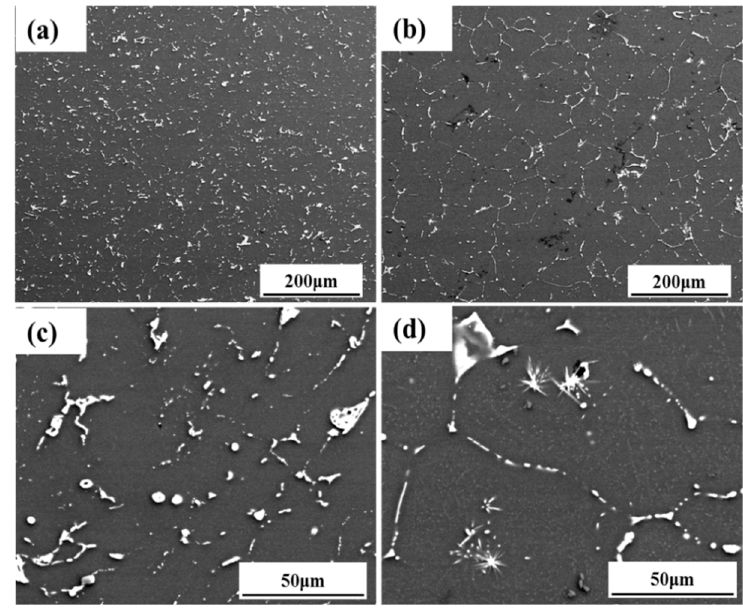
Figure 4. SEM images perpendicular to the extrusion direction of the extruded Mg-6Zn-0.5Nd-0.5/0.8Ca alloys. ( a ) is Mg-6Zn-0.5Nd-0.5Ca alloy; ( b ) is Mg-6Zn-0.5Nd-0.8Ca alloy; and ( c ) and ( d ) are the enlargement of ( a ) and ( b ), respectively.